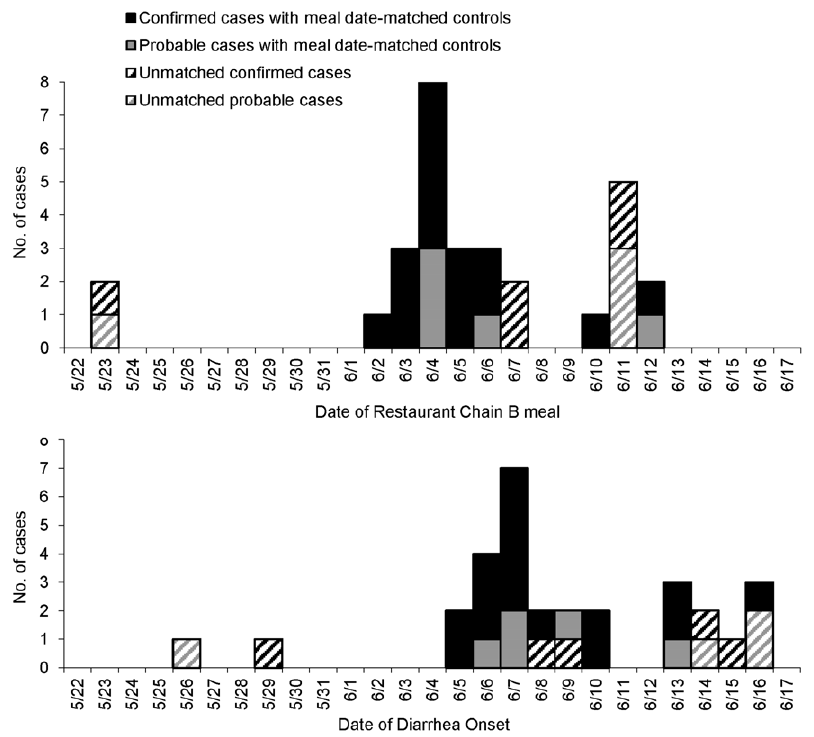
Figure 2. Restaurant B-associated cases by date of meal (top) and diarrhea onset (bottom). Solid black bars represent 16 confirmed cases with meal date-matched controls. Solid grey bars represent 5 probable cases with meal date-matched controls. The dashed black and grey bars represent 5 confirmed and 4 probable cases, respectively, that were not included in the matched analyses because they had no meal date-matched controls.